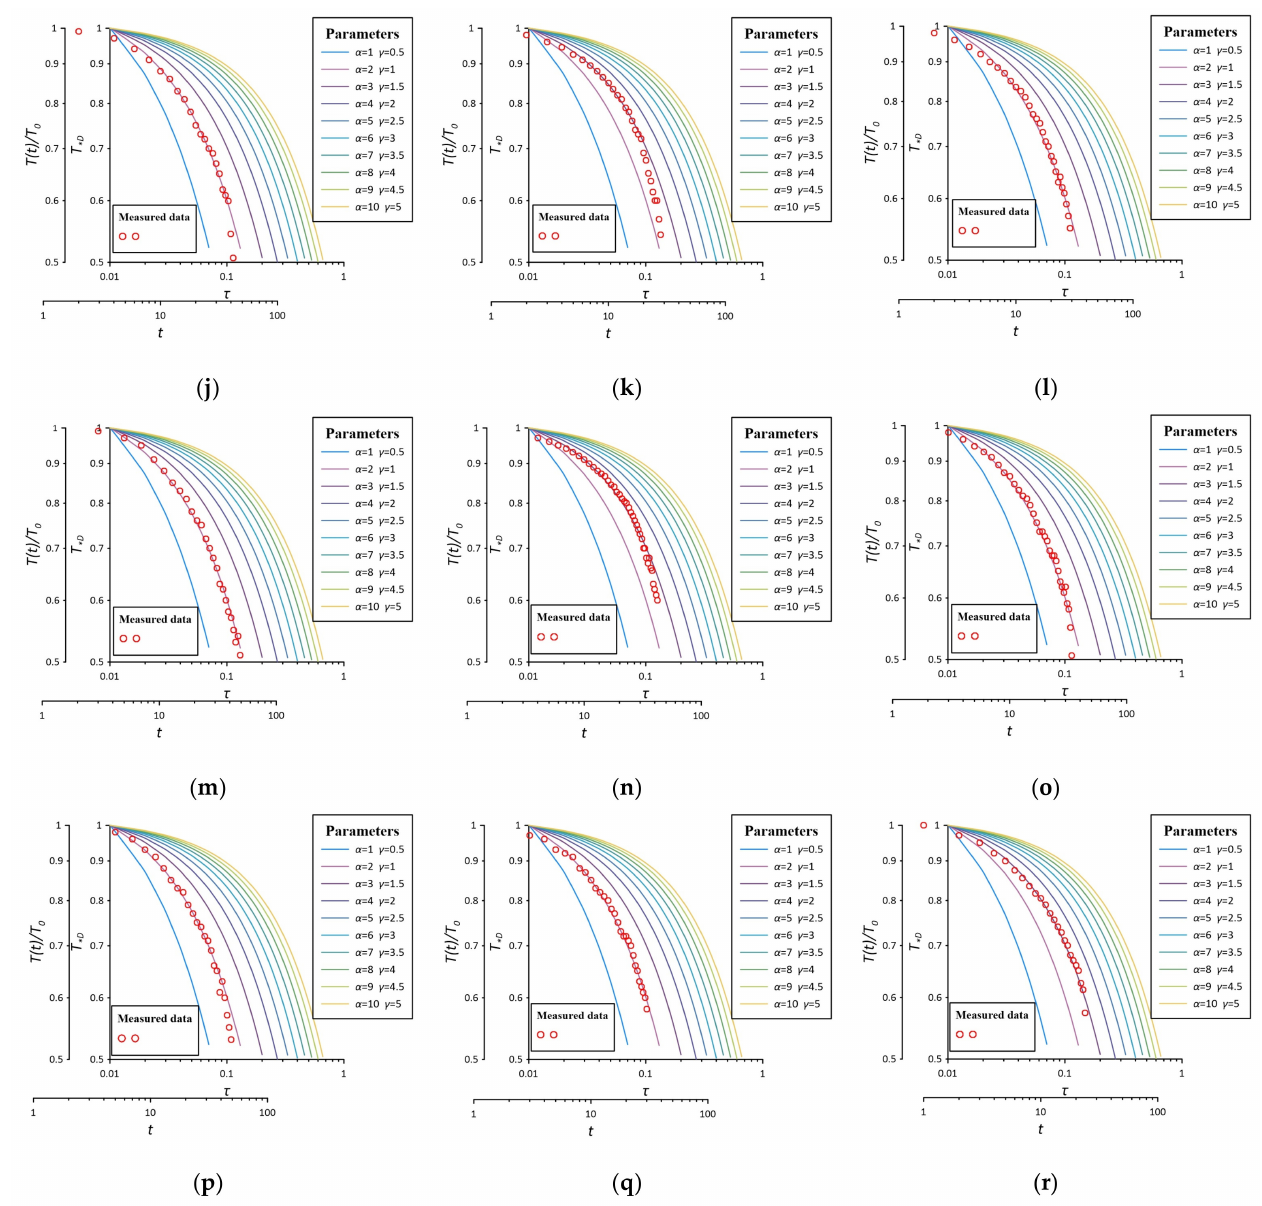
Figure 9. Matching diagram for different test conditions in the test well in the case of u (cid:54) = 0. ( a ) y ( ∆ h = 6 cm ∆ T = 2 ◦ C ) 1; ( b ) y ( ∆ h = 6 cm ∆ T = 2 ◦ C ) 2; ( c ) y ( ∆ h = 9 cm ∆ T = 2 ◦ C )